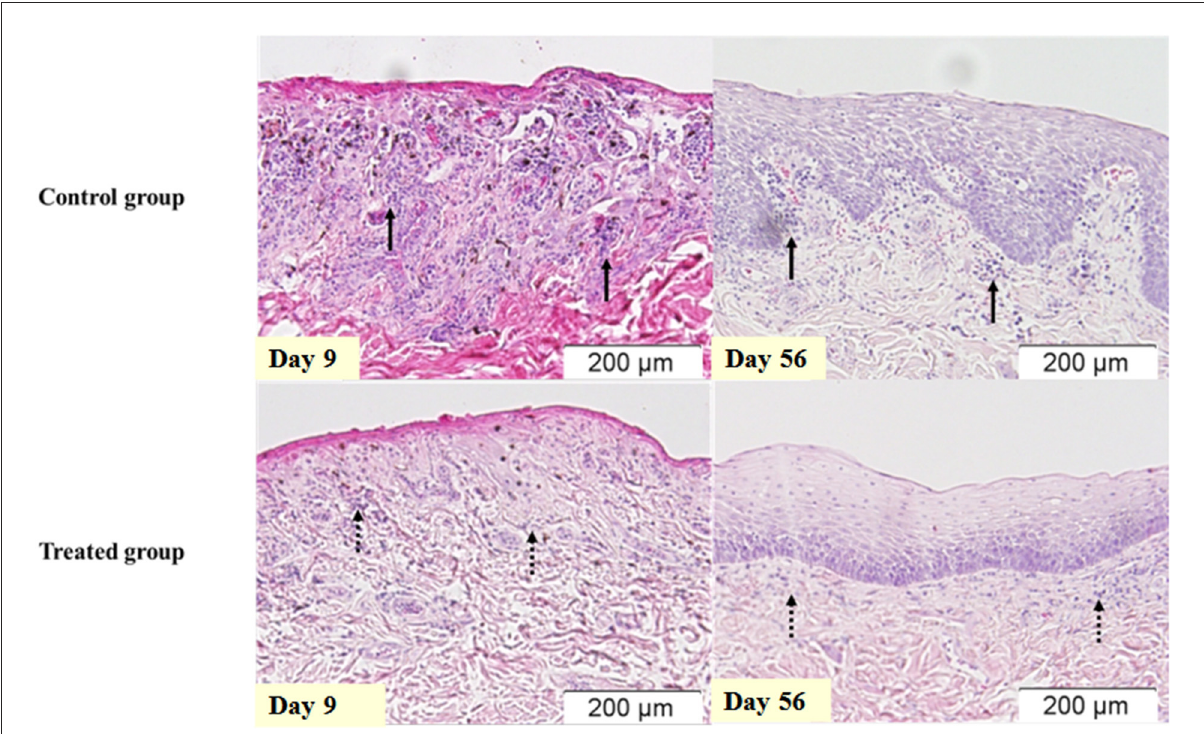
FIGURE2 Inflammatory infiltration of the oral mucosa after irradiation. Oral mucosa of same dogs in Figure 1, stained with hematoxylin and eosin. Infiltration of inflammatory cells is more prominent in the control group (solid arrow) when compared to the treated group (dashed arrow).